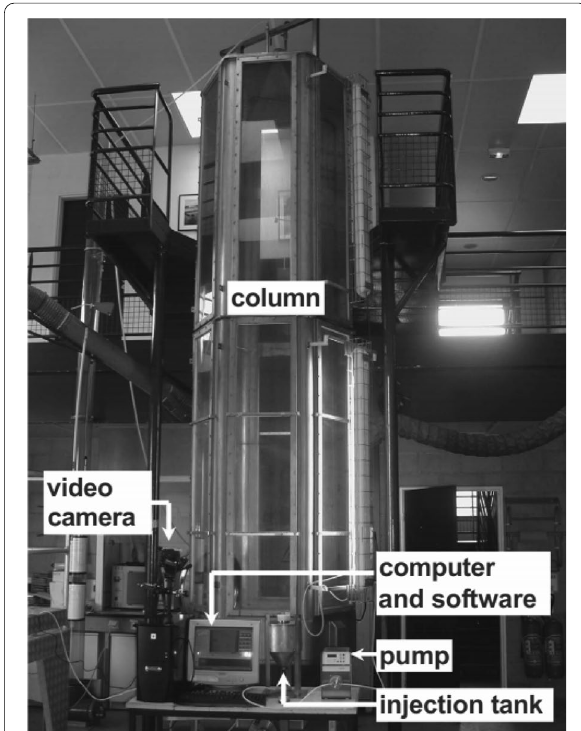
Fig. 4 Column testing tanks for the oil behaviours in the water column. Left: Cedre tests column: a hexagonal 5 m height and 0.8 m wide featured with 4 large windows dedicated to the study of the behavior of pollutant in the water column. Right as an example of work carried out in Cedre’s tests column, picture oil droplets treated with dispersant rising up towards the surface, stretched vertically by the friction with the ambient water and loosing tiny oil droplets during their ascent (Stéphane et al.